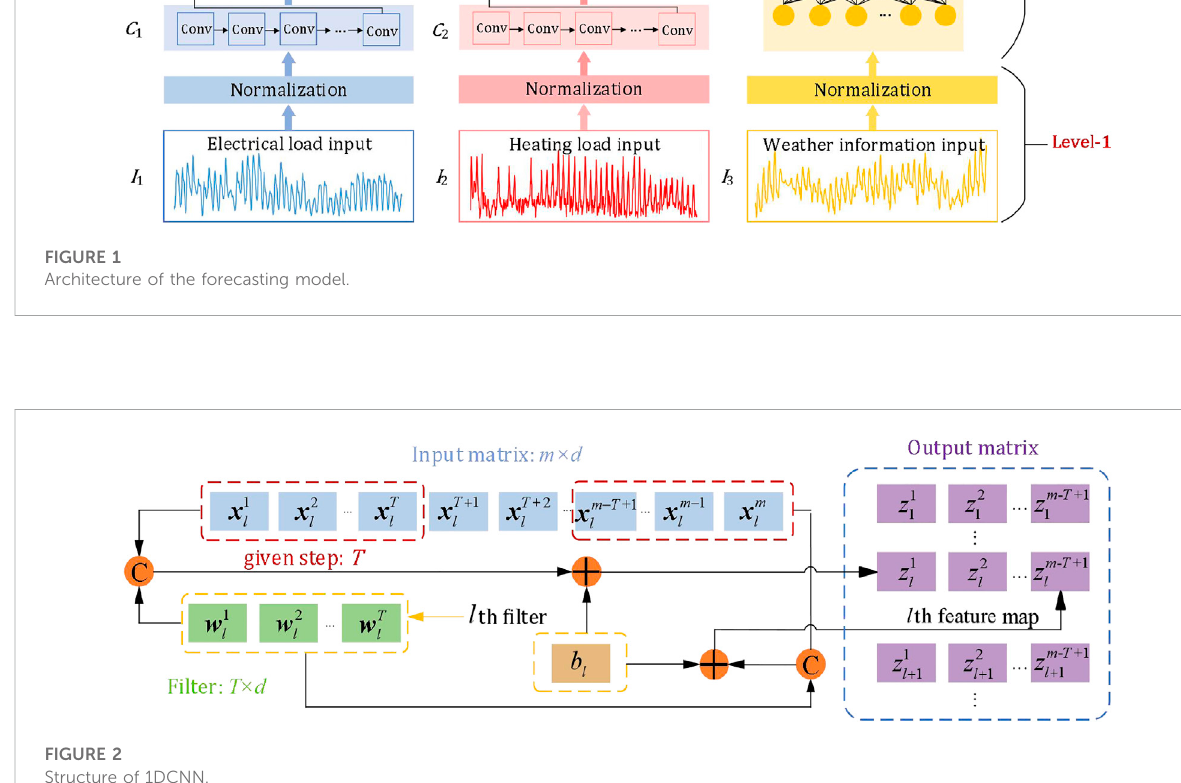
FIGURE 2 Structure of